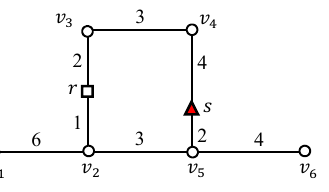
Figure 2. Example where dist ( r , s ) = 6 and len ( r , s ) = 9 .